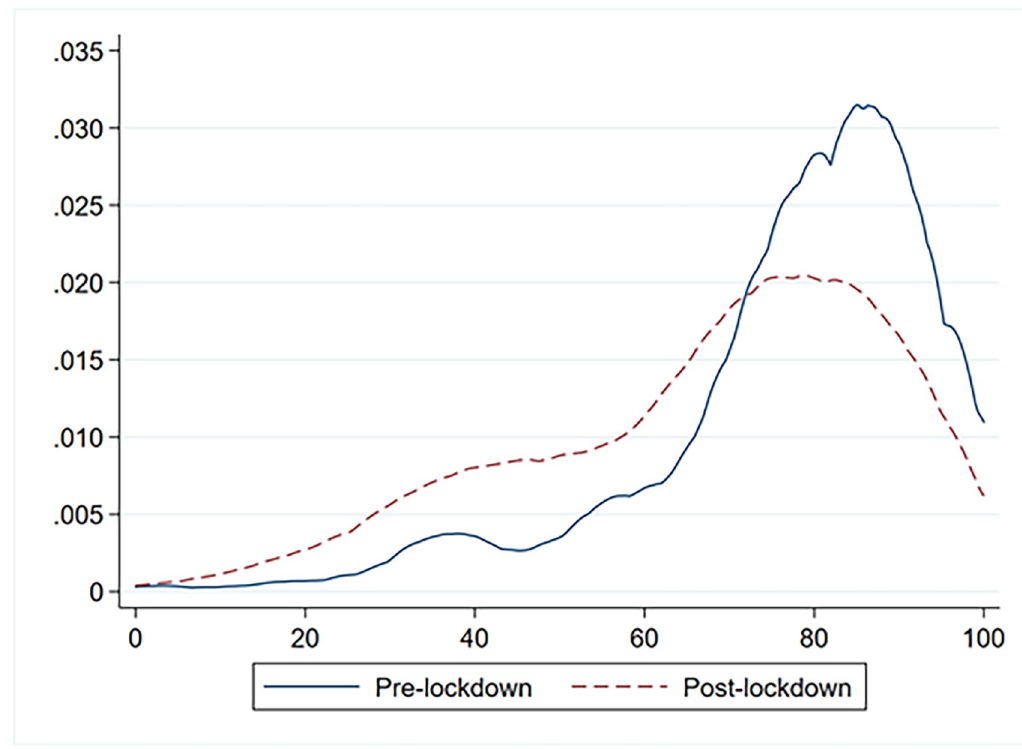
Fig 1. Kernel distribution of the pre- and post-Covid mental health latent-trait